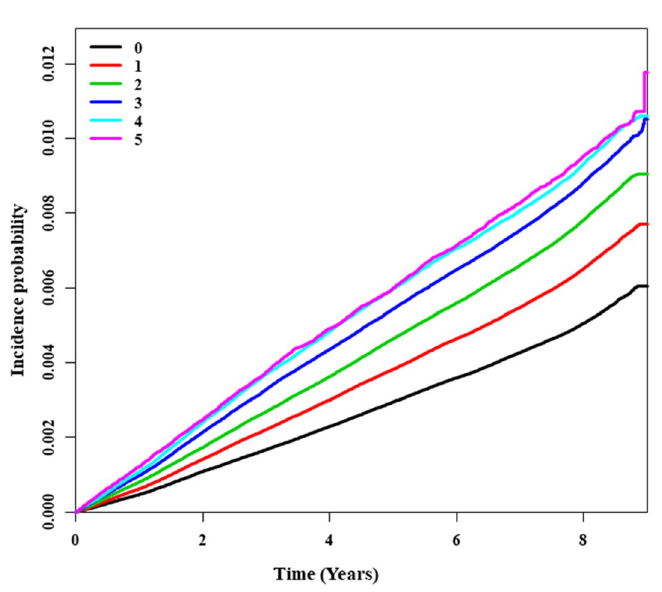
Figure 4. Incidence of OSA over the 10-year follow up period according to the numbers of MetS components (all components; log-rank test, p <